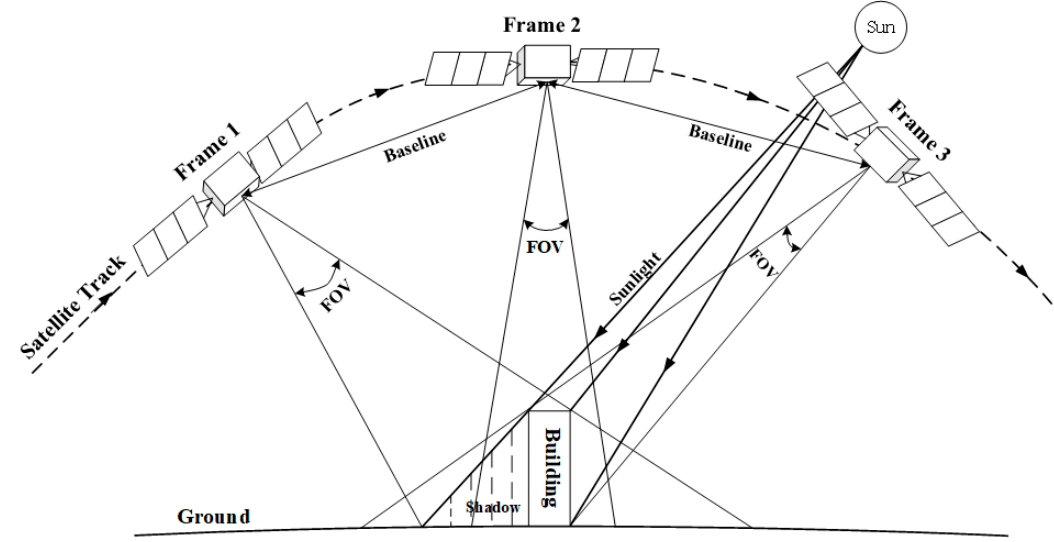
Figure 1. The method of capturing image sequence by agile satellites.